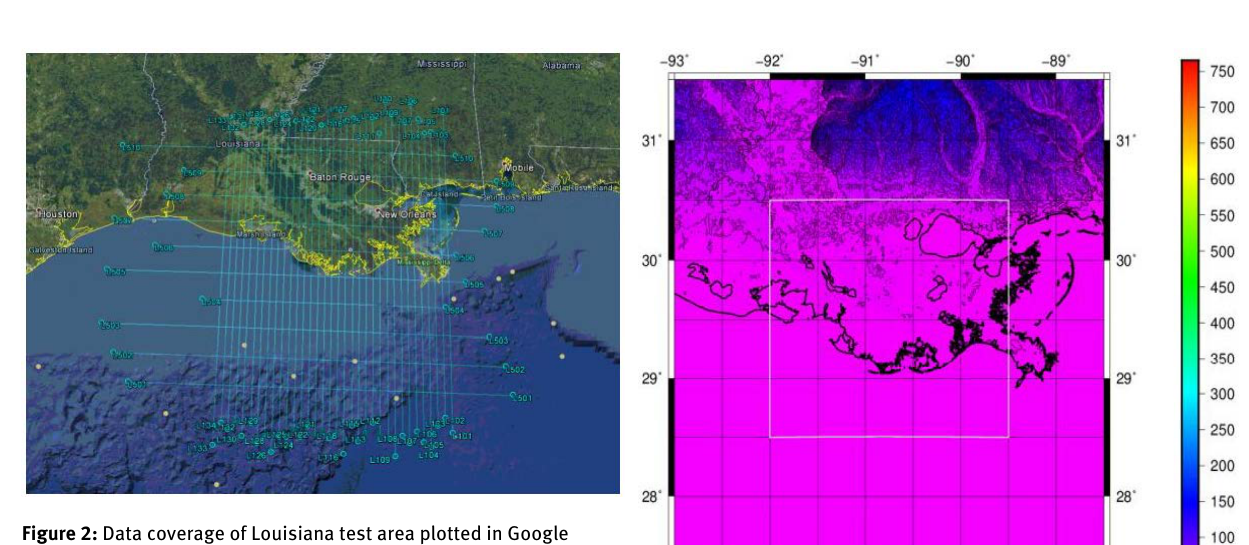
Figure 2: Data coverage of Louisiana test area plotted in Google Earth